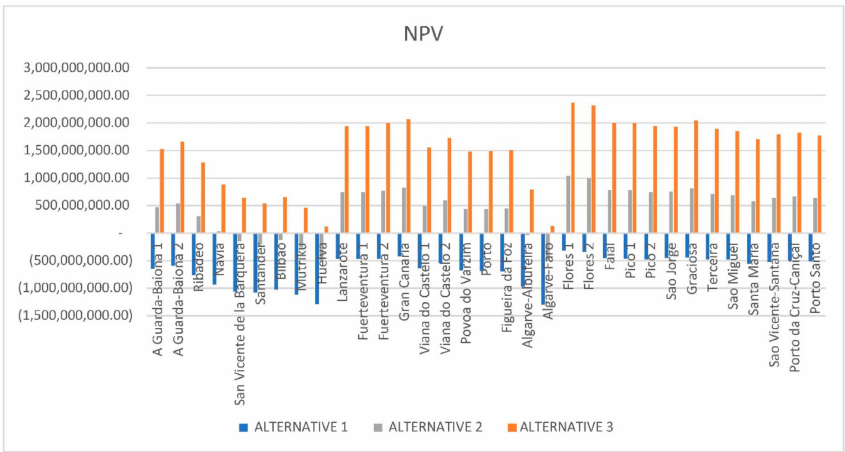
Figure 12. Net present value (NPV)